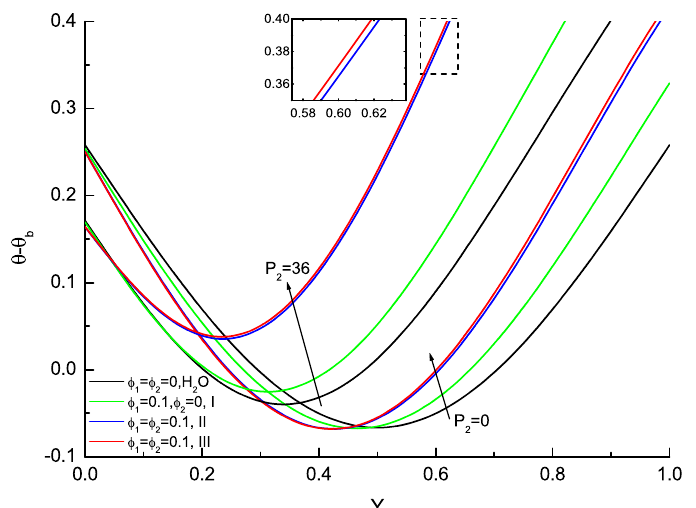
Figure 3. Variation with P 2 of the velocity profiles for the base fluid ( H 2 O ), nanofluid ( Cu - H 2 O , type I) and hybrid nanofluid ( Cu - Al 2 O 3 - H 2 O , type II & III) at P 1 = 100.